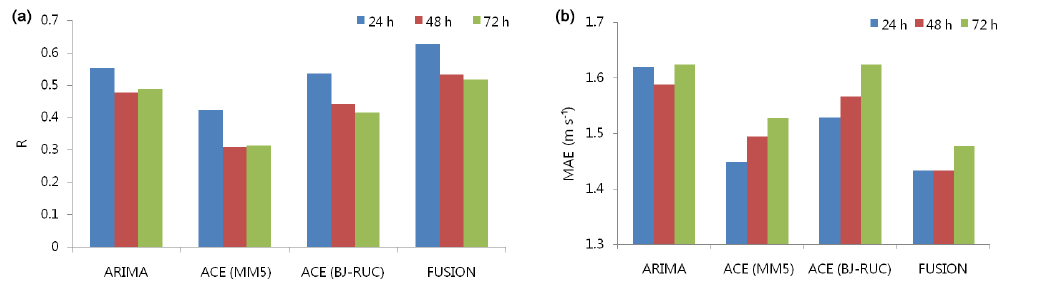
Figure 2. The contrast of the correlation coefficient (a) and mean absolute error (b) during each step.